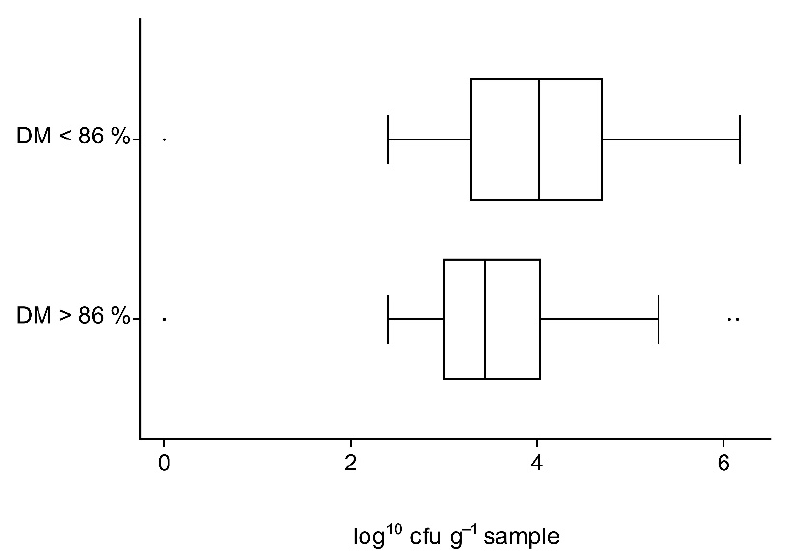
Figure 4. Distribution of mold counts (log 10 cfu g − 1 sample) in grain samples with dry matter con- tents of ≥ 86% and <86%.